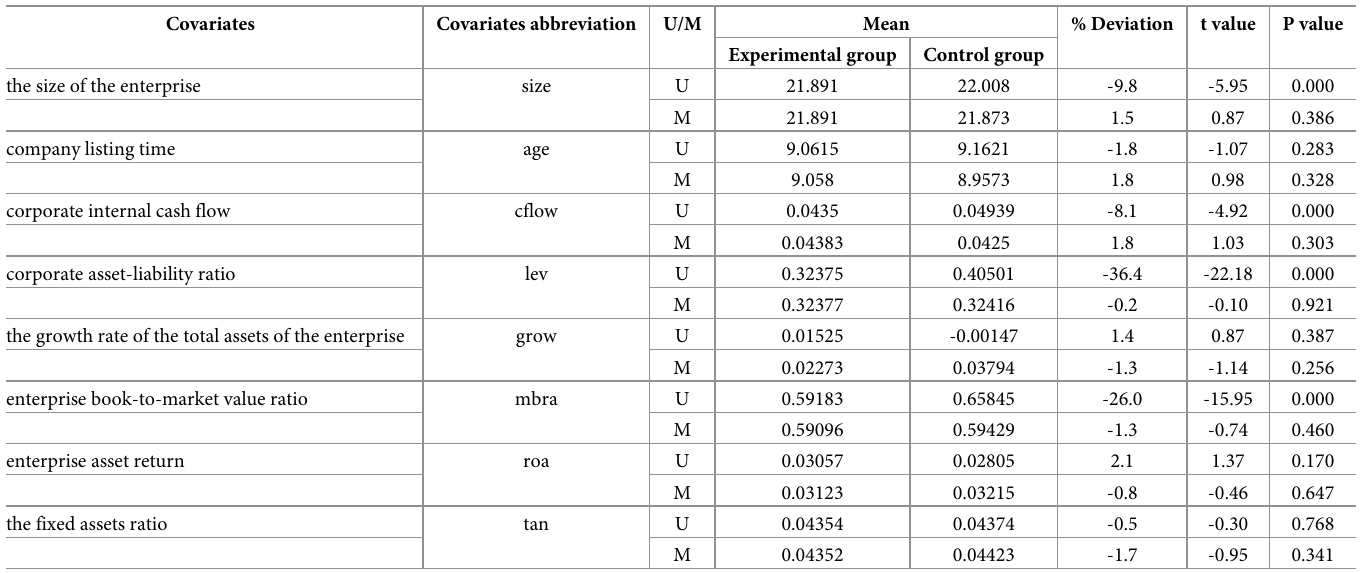
Table 2. Balance test before and after PSM